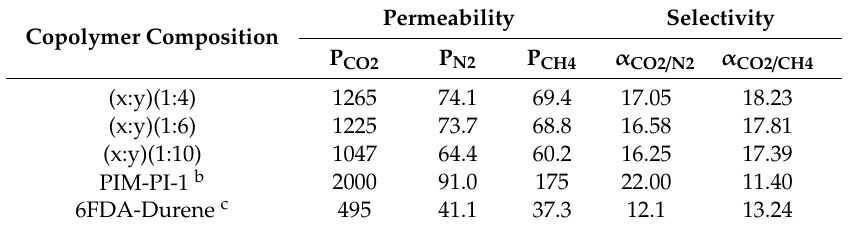
The pure gas separation properties of the obtained three [(PIM-PI)x-(6FDA-durene-PI)y] (x:y = 1:4, ◦ 1:6 and 1:10) copolymer membranes were determined at 30 C and 2 atm pressure using the constant-volume / variable-pressure method (Table 2) by monitoring the increase of downstream − 3 pressure upto 2 Torr (2.7 × 10 bar). Table 2. Gas permeability a and selectivity of the [(PIM-PI)x-(6FDA-durene-PI)y] copolymer, PIM-PI-1 and 6FDA-durene homopolymer membranes at 30 °C and 2 atm pressure. Permeability Selectivity Copolymer Composition